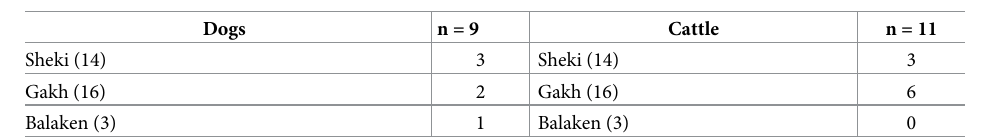
PLOS ONE | https://doi.org/10.1371/journal.pone.0248572 November18, 2021 5 /